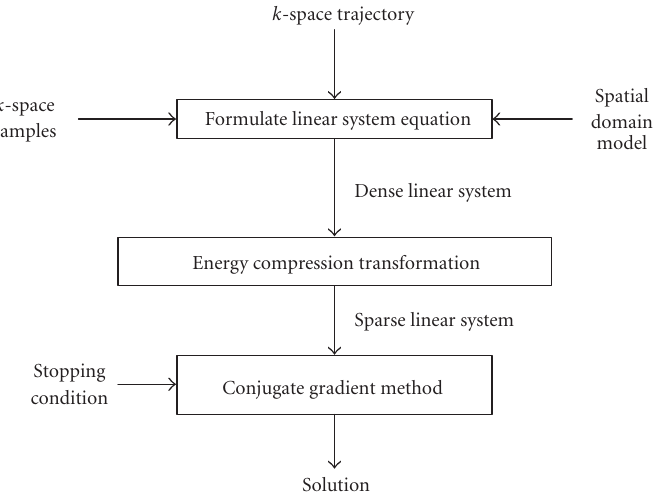
Figure 1: A block diagram of the developed reconstruction